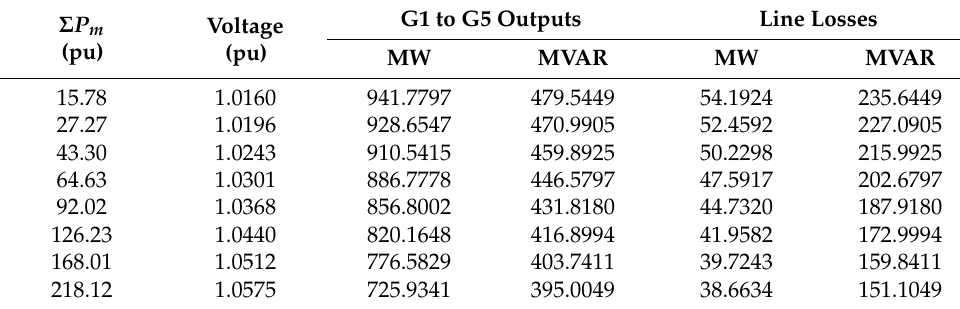
Table 9. WPP voltages, G1 to G5 power outputs and line losses (PF = 1.0).